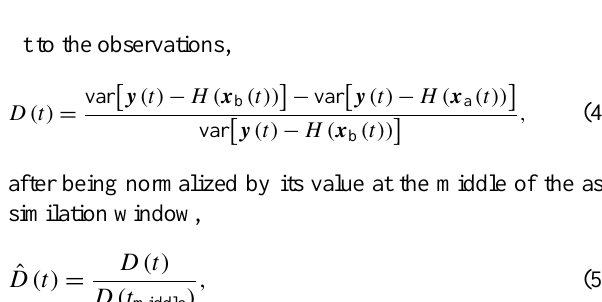
Fig. 11. Same as the previous figure, except showing the difference in standard deviation relative the ERA-Interim reanalyses for the 4D-Var and 3D-Var experiments for the February/March 2011